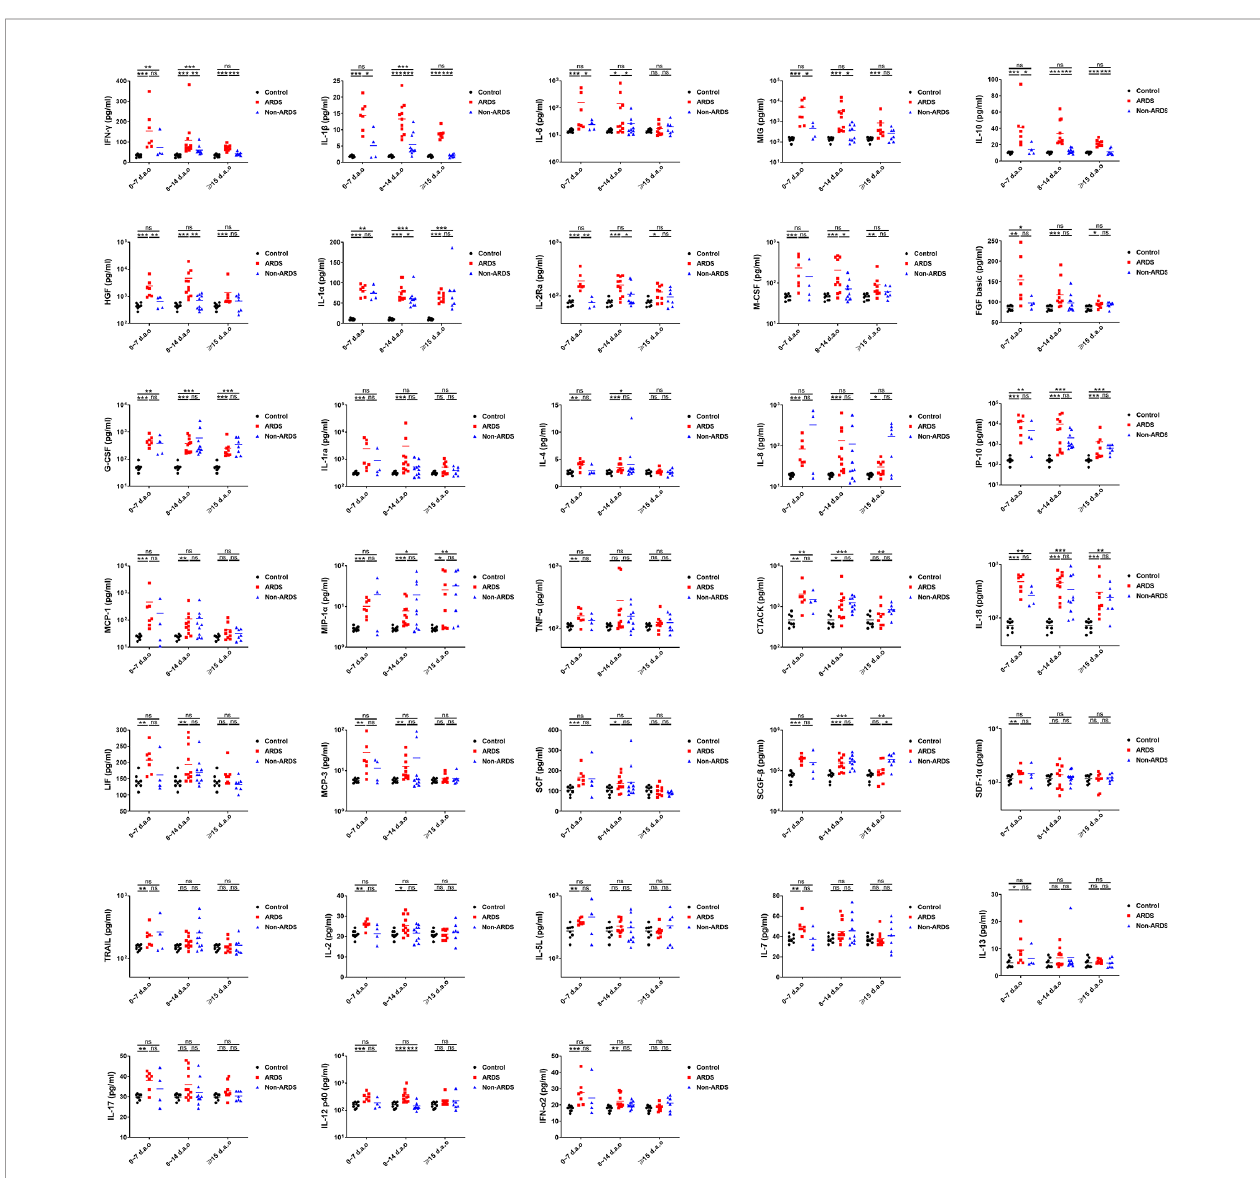
FIGURE 2 | Comparison of cytokines/chemokines showing signi fi cant increases in HAdV patients with or without ARDS during disease progression. Expression of 33 cytokines/chemokines measured at different days after illness onset were compared between HAdV patients with or without ARDS. P = 0.01 – 0.05, 0.001 – 0.01 and 0.0001 – 0.001 was considered signi fi cant (*), very signi fi cant (**) and extremely signi fi cant (***), respectively, whereas ns represents not signi fi